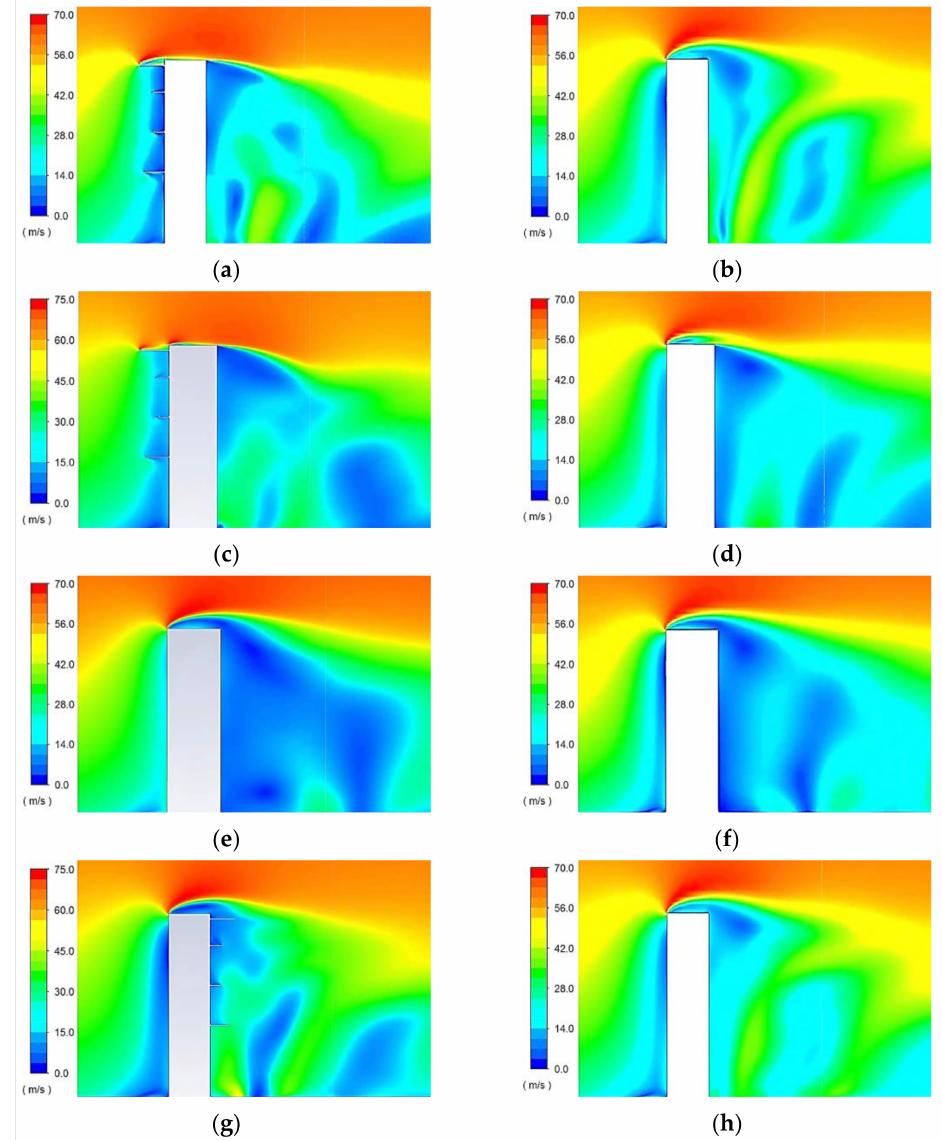
Figure 10. Velocity magnitude in the XY plane at Z = 0 m. ( a ) Case 1. The target model, θ = 0 ◦ ; ( b ) Case 2. The reference model, θ = 0 ◦ ; ( c ) Case 3. The target model, θ = 30 ◦ ; ( d ) Case 4. The reference model, θ = 30 ◦ ; ( e ) Case 5. The target model, θ = 90 ◦ ; ( f ) Case 6. The reference model, θ = 90 ◦ ; ( g ) Case 7. The target model, θ = 180 ◦ ; ( h ) Case 8. The target model, θ = 180 ◦ .